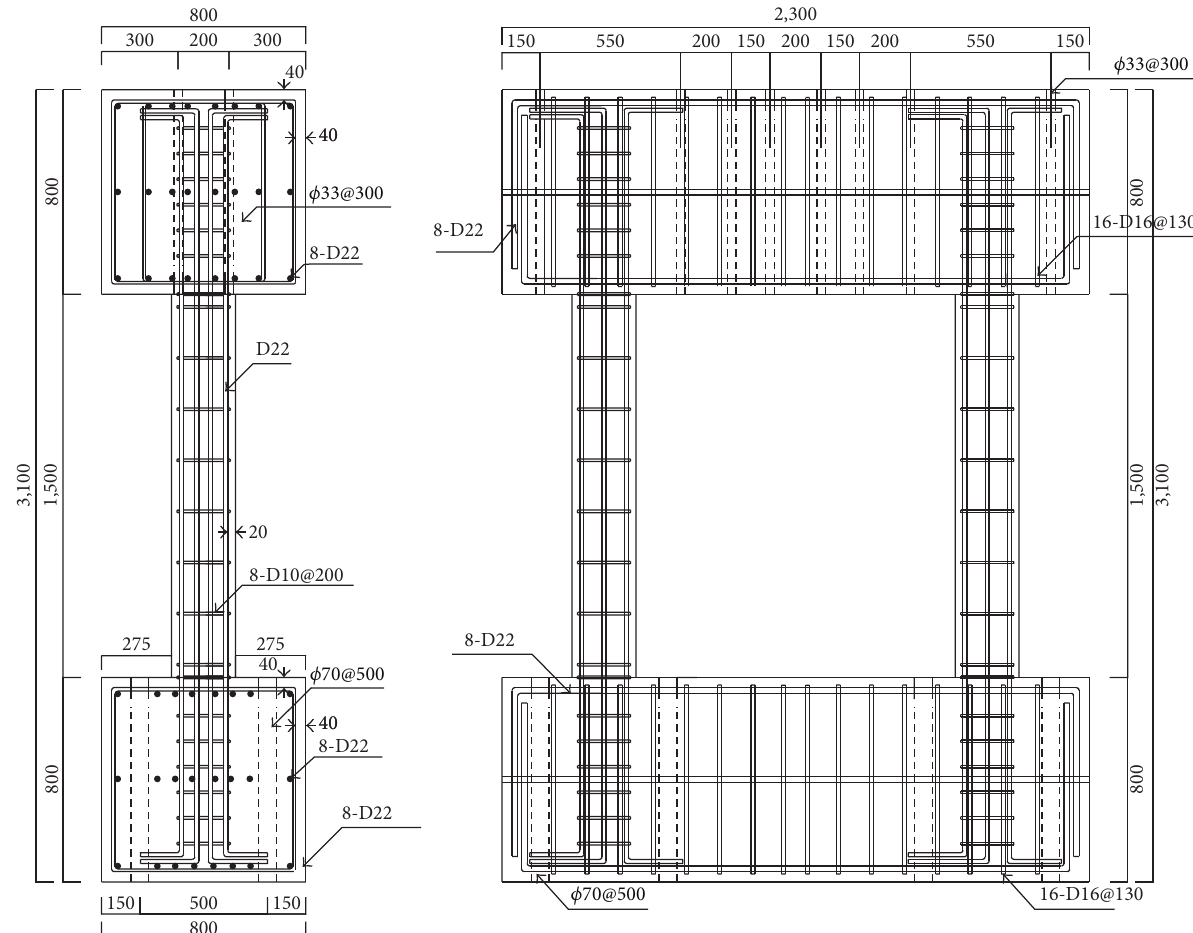
Figure 2: Details of the SF-series of control specimens (dimensions are in mm).